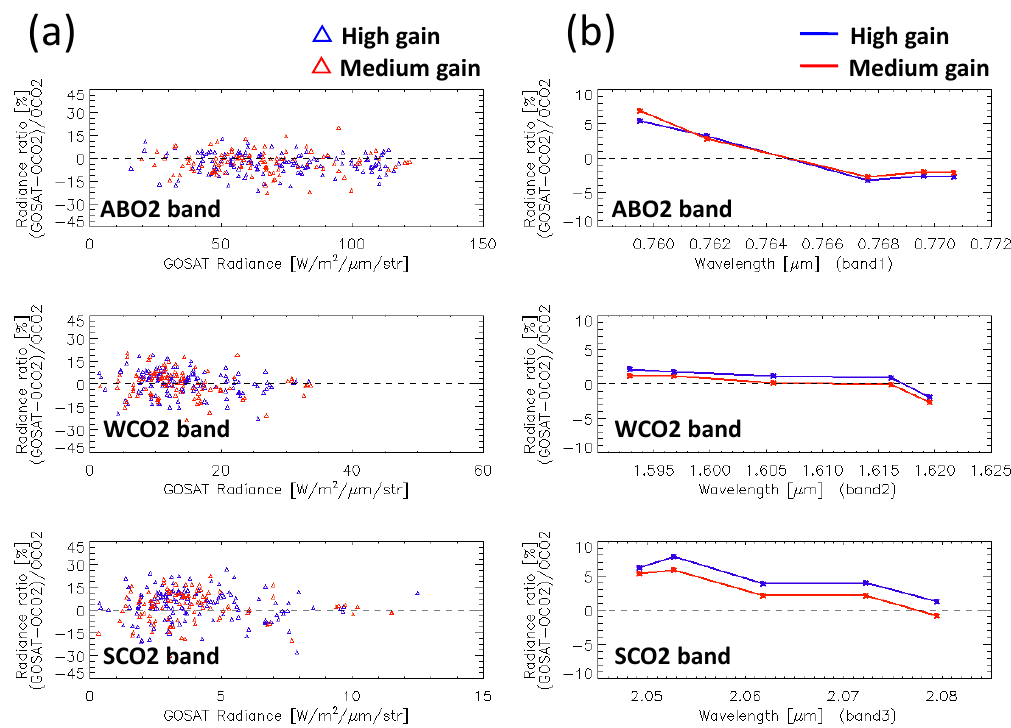
Figure 5. ( a ) The fractional difference in spectral radiance for GOSAT and OCO-2 is shown as a function of the GOSAT radiance amplitude. Blue and red dots represent high and medium gains, respectively; ( b ) Spectral radiance ratio at the center of wavelengths shown in Figure 2. For both panels ( a , b ), the upper, middle and lower figures represent the ABO2, WCO2 and SCO2 bands, respectively.